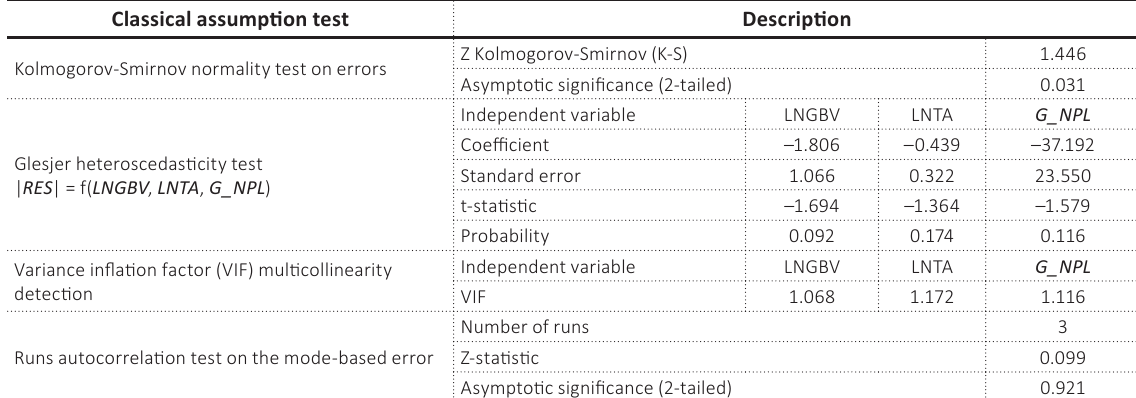
Source: Modified output of IBM SPSS